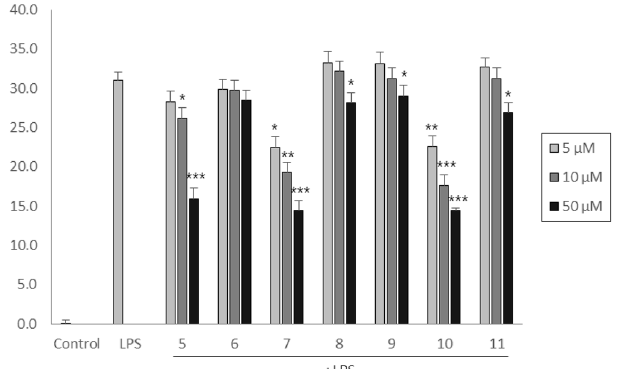
Figure 4. Inhibitory effects of compounds 5–11 on LPS-induced NO production in RAW 264.7 macrophage